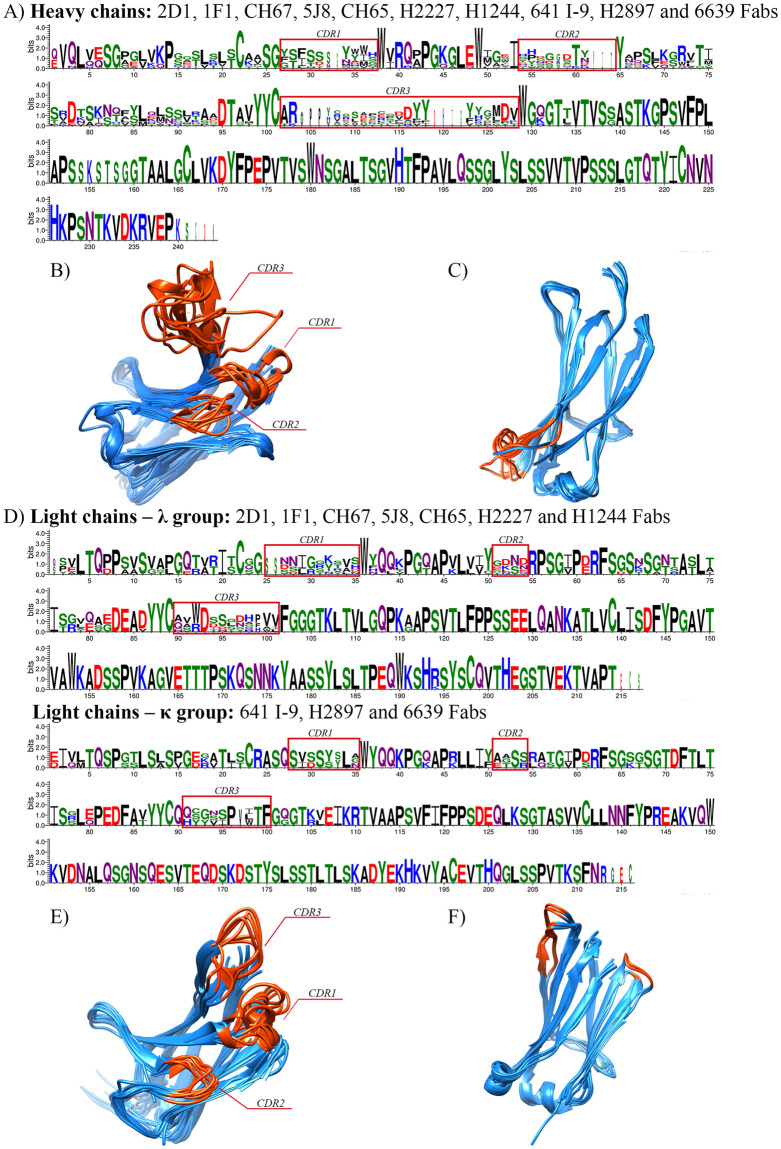
Multiple sequence alignment (MSA) and superimposition of ten heavy/light chains of broad-spectrum Fab templates against the H1 influenza A virus.MSA of (A) heavy chains and (D) light chains was done by the MEGA-X program. The amino acids’ logo was drawn using WebLogo version 3.7.4 with auto background composition and colored by chemical properties: Green—polar, purple—neutral, blue—basic, red—acidic, and black—hydrophobic amino acids. 3D-structure superimposition of variable regions (B and E) and constant regions (C and F) of heavy and light chains, respectively, as illustrated by UCSF Chimera 1.13.1 and colored by the difference in 3D conservation of structure: Blue—high and orange—less conservation.